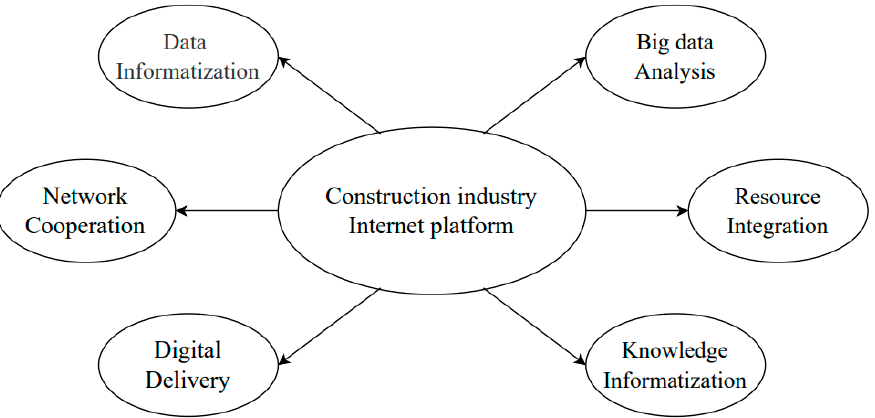
Figure 1. Main features of the construction industry Internet